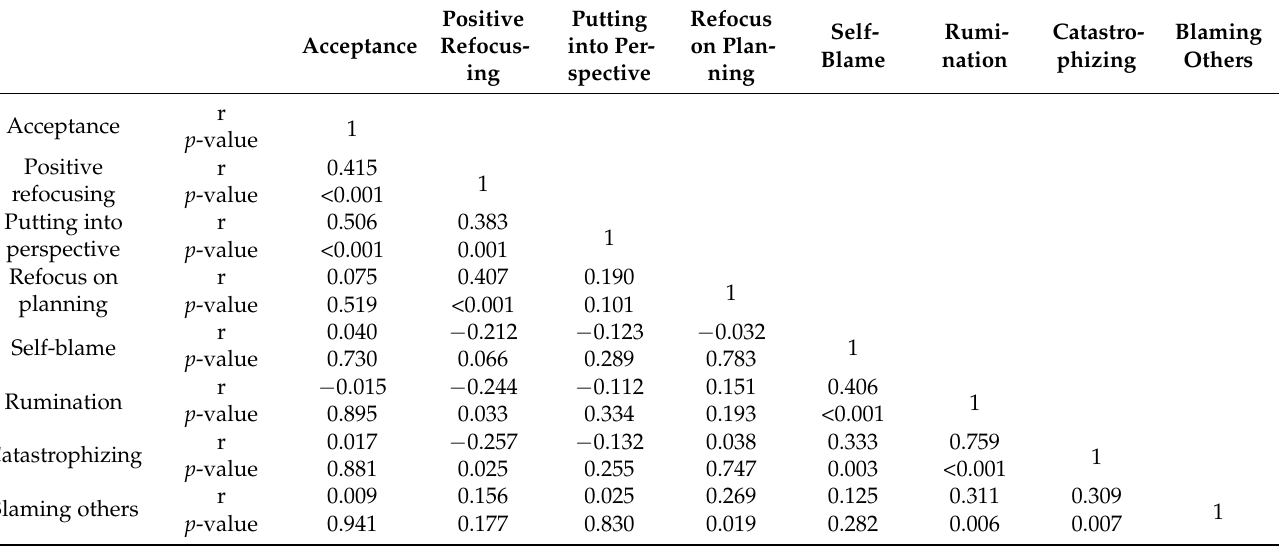
Table 3. Coefficient of correlation of cognitive strategies among cancer